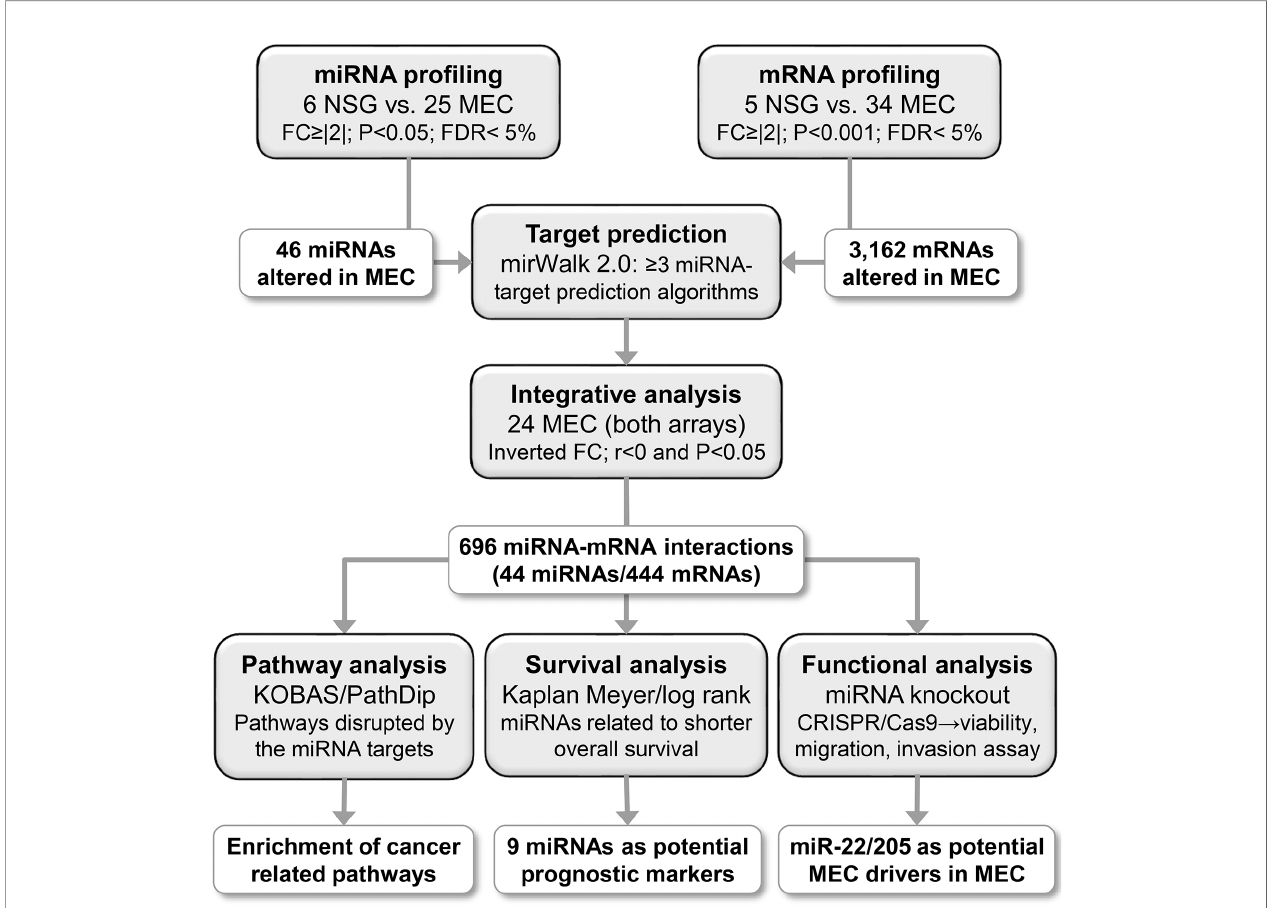
FIGURE 1 | Study design and main results obtained from the miRNA and mRNA expression analyses. First, a miRNA and mRNA global expression analyses revealed 46 miRNAs and 3,162 mRNAs differentially expressed in MEC compared to SNG. An integrative analysis was carried out using predicted miRNA-mRNA interactions, generating a network containing 44 miRNAs and 444 mRNAs (696 interactions). The target genes were associated with cancer-related pathways, and nine miRNAs were associated with shorter overall survival. A knockout assay was performed for miR-22 and miR-205 (CRISPR/Cas9), resulting in viability, migration, and invasion reduction, which indicate their role as putative cancer drivers in